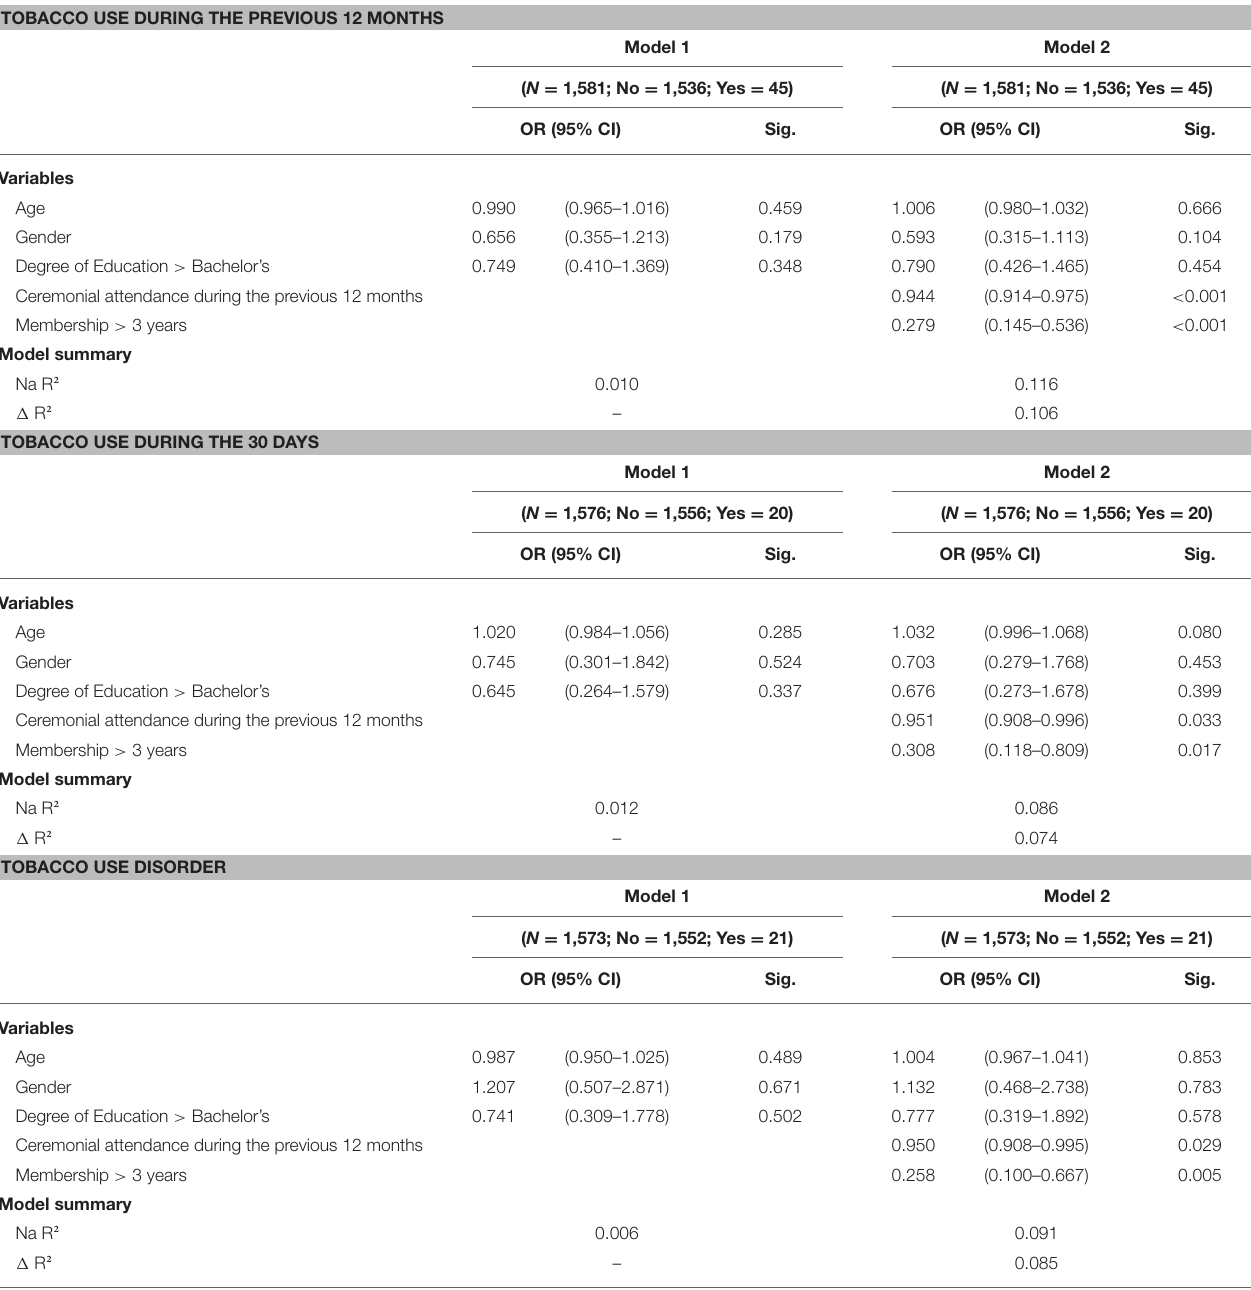
TABLE 6 | Hierarchical logistic regressions for tobacco use during the previous 12 months, previous 30 days and tobacco use disorder. TOBACCO USE DURING THE PREVIOUS 12